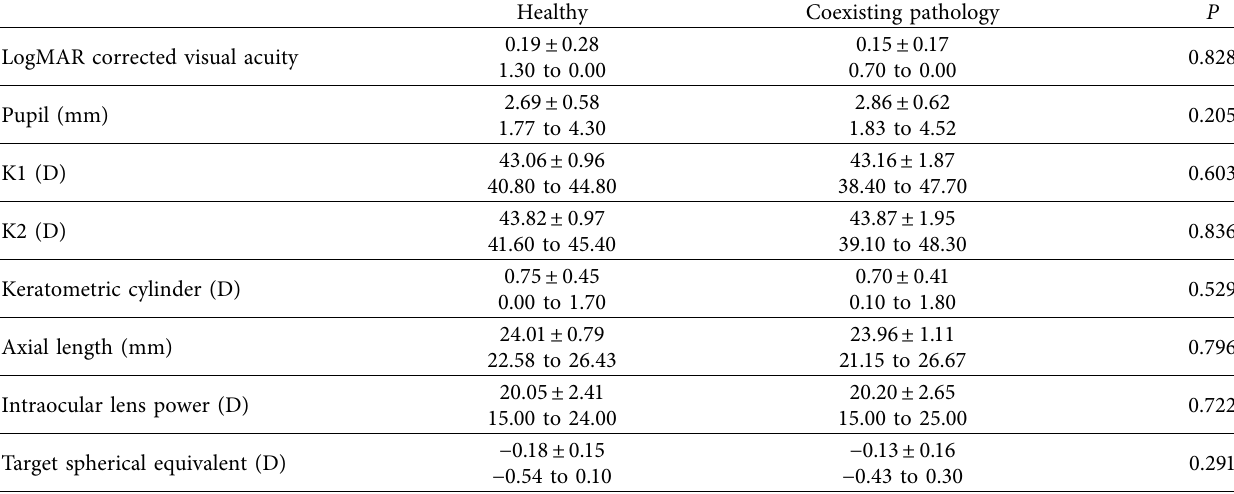
Table 1: Preoperative characteristics of the eyes included in the study. mm: millimeters; D: diopters.